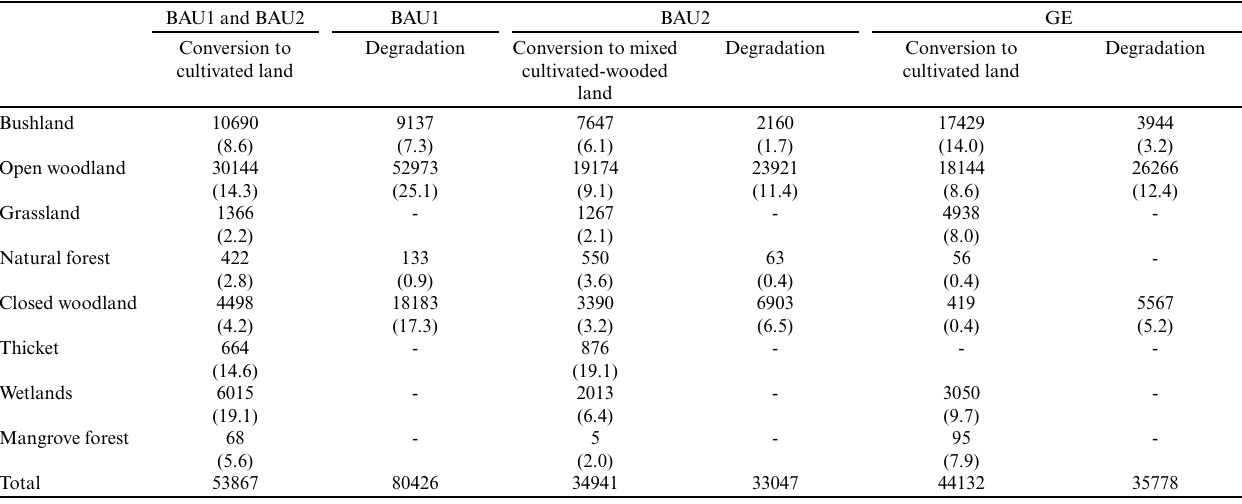
Table 2 . Land use and land cover changes simulated under business as usual (BAU) and green economy (GE) scenarios. In BAU scenario, under two patterns of agriculture sector expansion (BAU1 and BAU2), cultivated land increases by 30% of cropland area in the reference map (MNRT 2013). In the BAU2 pattern, additional expansion of mixed cultivated-wooded land is simulated. For every scenario and pattern, additional degradation of wooded areas occurs to fulfill wood demand, spatially segregated from cultivated land expansion. Surfaces areas are reported in km², and percentages of the original land cover are given in parentheses for each class.